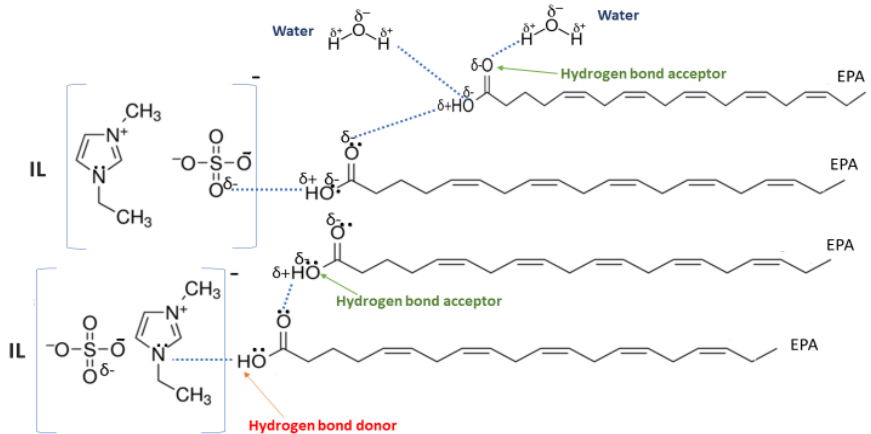
Figure 5. Proposed hydrogen bonding between the IL, [EMIM] + SO 42 − , EPA, and water available in the system during extraction.